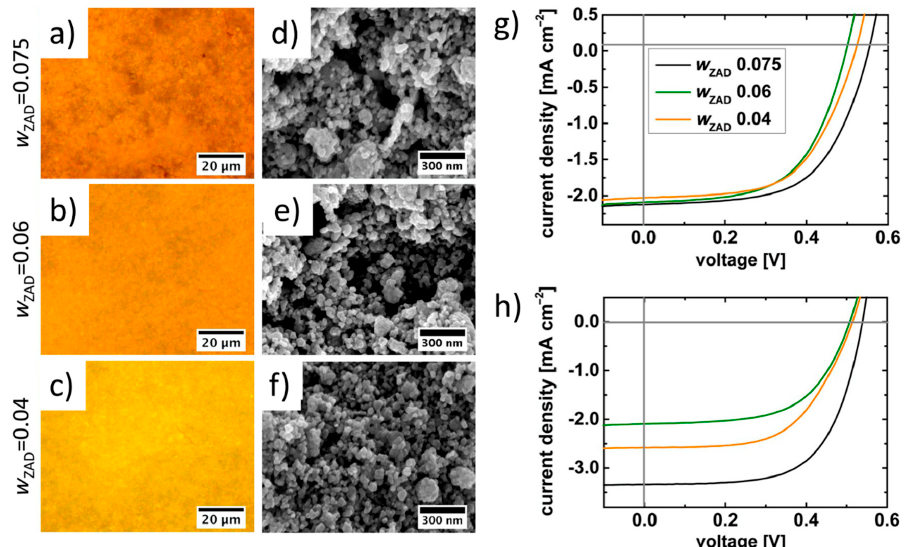
Figure 10. Applications in dye-sensitized solar cells (DSSCs): ( a – c ) optical microscope images and ( d – f ) SEM images of screen-printed films prepared from pastes obtained from sol-gel ZnO nanoparticles using 0.075, 0.06, 0.04 weight fractions of the ZnO precursor respectively. ( g , h ) J–V characteristics for DSSCs fabricated from different ZnO nanoparticles-based pastes with two different film thicknesses of the active layer. Reproduced with permission from Reference [96] Copyright 2015, WILEY-VCH.